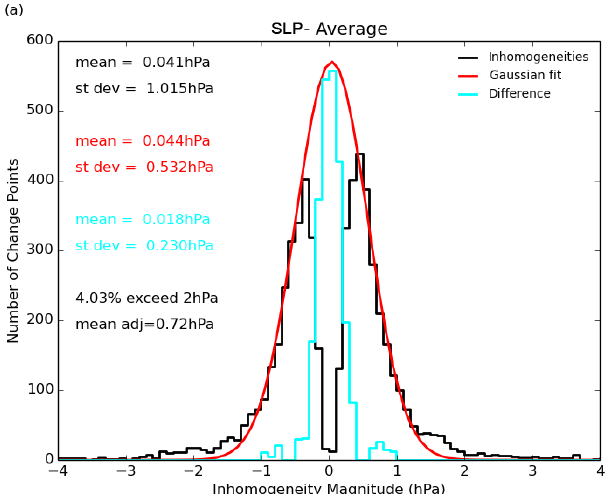
Fig. 8. The distribution of the inhomogeneity magnitudes for monthly mean SLP. The distributions have been fitted with a Gaus- Figure 8. The distribution of the inhomogeneity magnitudes for sian (red), and the difference between the data and the Gaussian is monthly-mean SLP. The distributions have been fitted with a Gaus- shown in blue. sian (red), and the difference between the data and the Gaussian is shown in